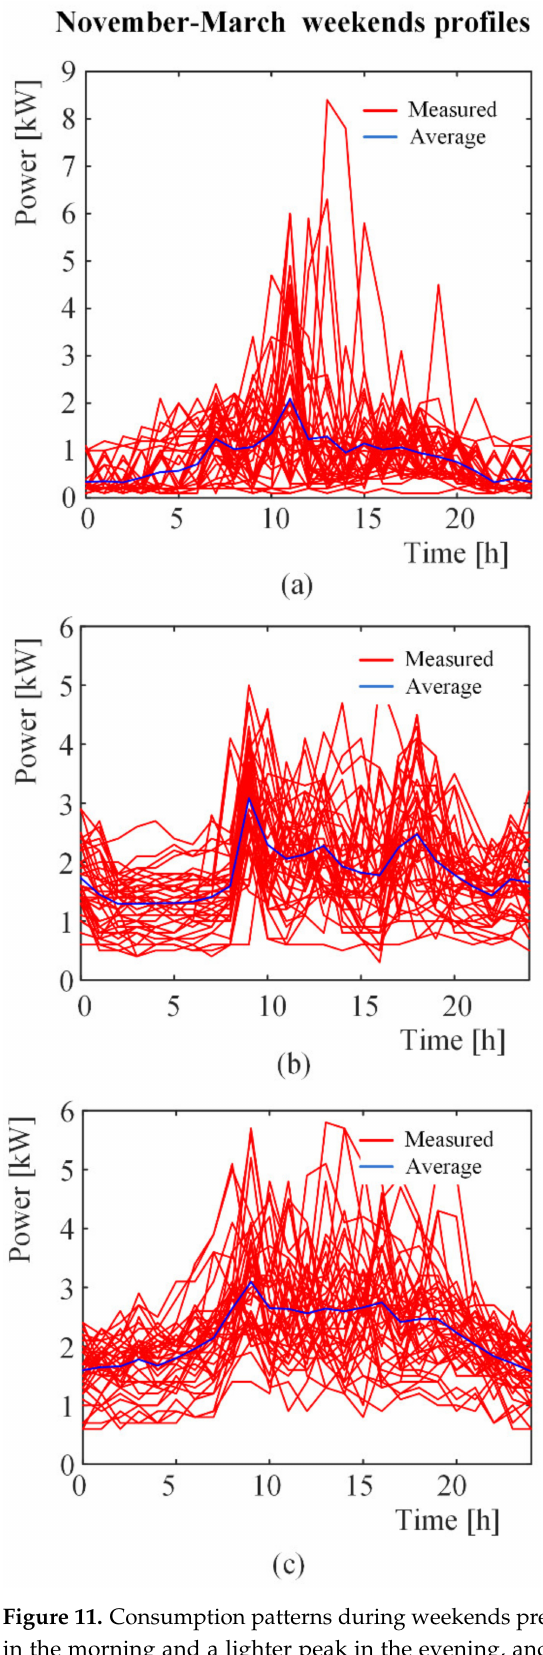
Figure 11. Consumption patterns during weekends presenting ( a ) a peak in the morning, ( b ) a peak in the morning and a lighter peak in the evening, and ( c ) a peak in the morning and then slowly decreasing load